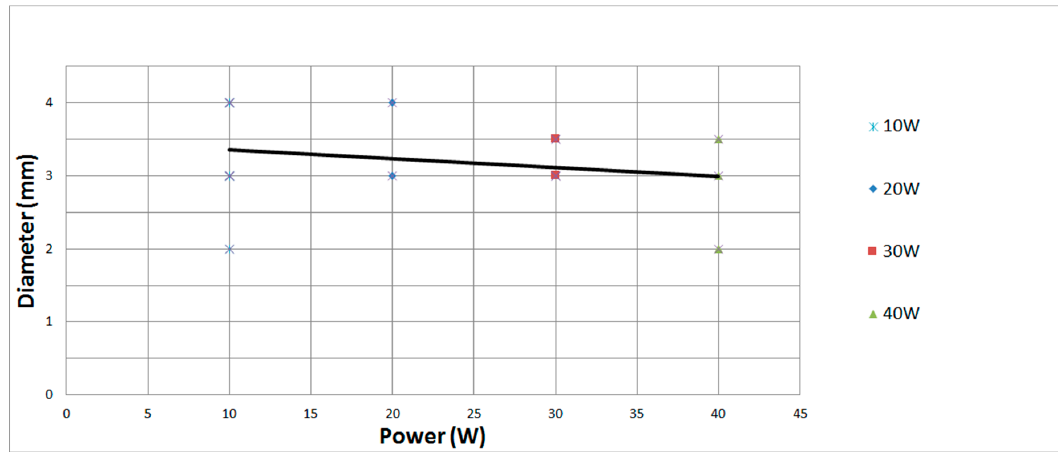
Figure 5. Microscopic necrosis at different ablation powers (10, 20, 30, 40 W). Central coagulative necrosis seen at histology ( Y -axis) was not significantly different among the ablation powers applied ( X -axis).